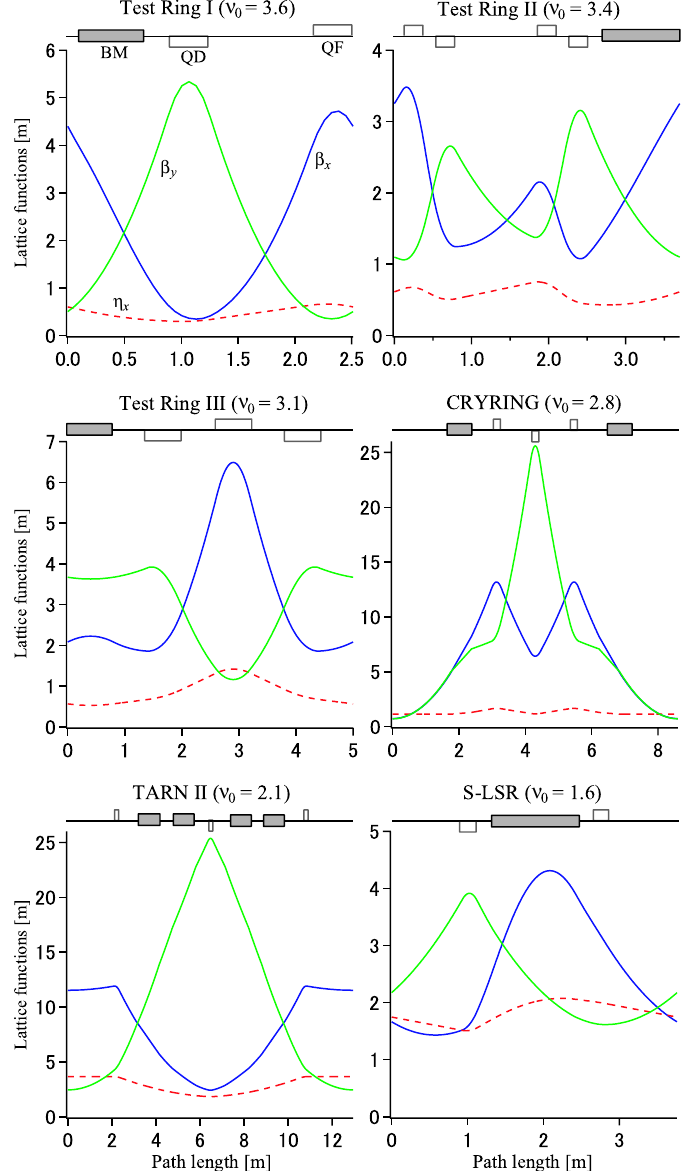
FIG. 7. (Color) Lattice functions of the test rings considered in Sec. IV. (cid:3) dispersion function. All the transverse tunes are set equal (cid:3) (cid:2)